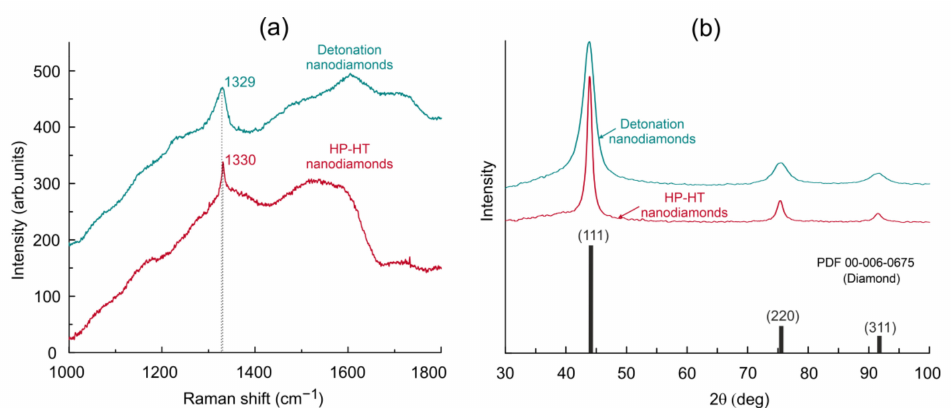
Figure 2. ( a ) Raman spectra of HP-HT and detonation nanodiamonds film and ( b ) X-ray diffraction patterns of HP-HT and detonation nanodiamond powders. The X-ray diffraction pattern of diamond (Powder Diffraction File 00-006-0675) is presented for a